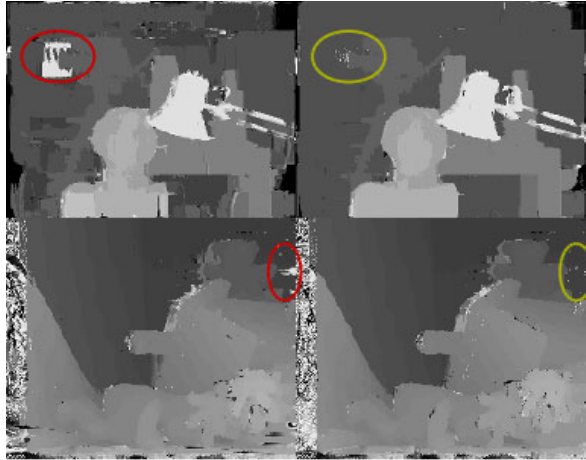
Figure 1. Disparity maps for the Tsukuba (above) and Teddy (below) stereo pairs obtained via the default census transfor- mation (left) and census on gradients (right) after the aggrega- tion step. Indicated are examples for areas of